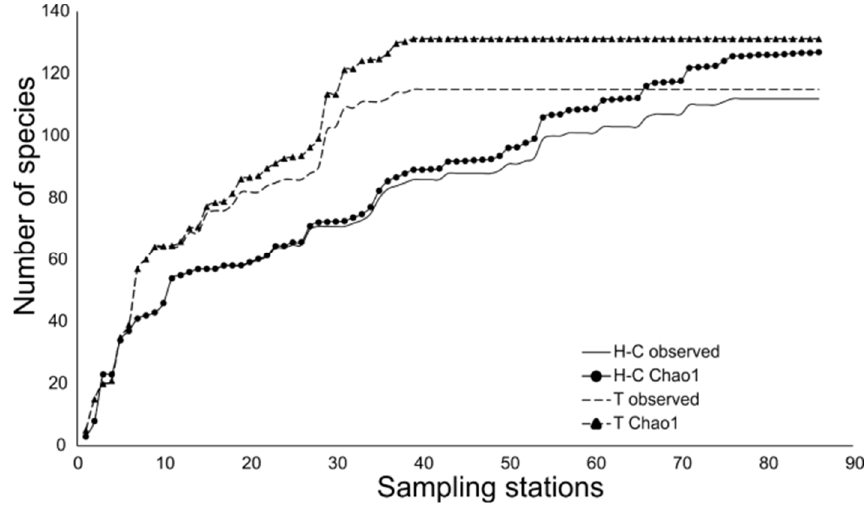
Figure 3. Fish species accumulation model for the different estuarine systems studied. The model used was Chao1.